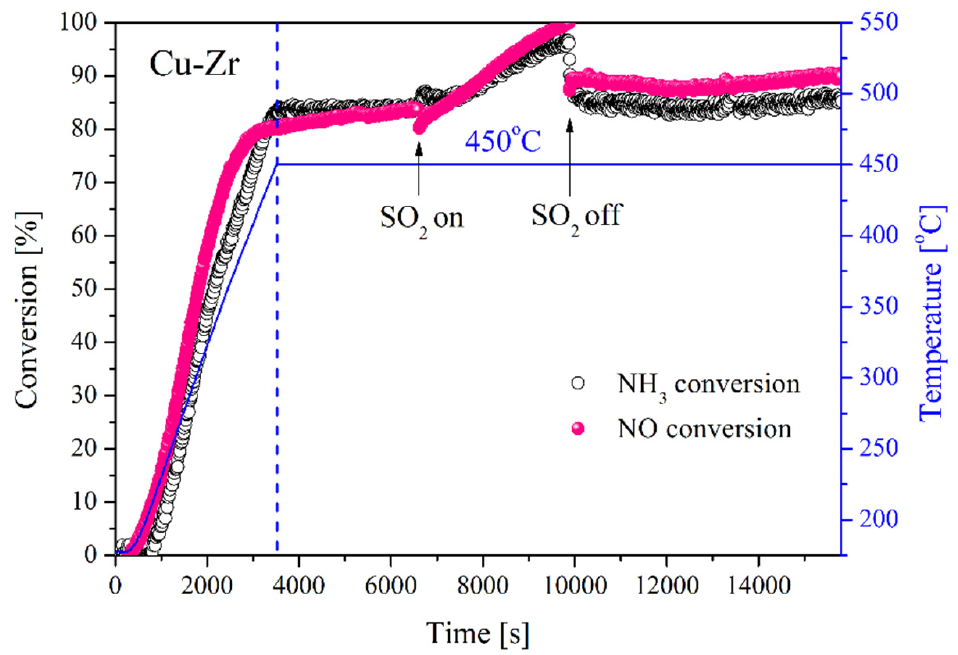
Figure 7. Effect of SO 2 addition during NH 3 -SCR over Cu-Zr catalyst in the absence of water. The experimental conditions: [NO] = [NH 3 ] = 1000 ppm, [SO 2 ] = 100 ppm when used, [O 2 ] = 2.5 vol% diluted in helium; total flowrate of 100 mL/min.